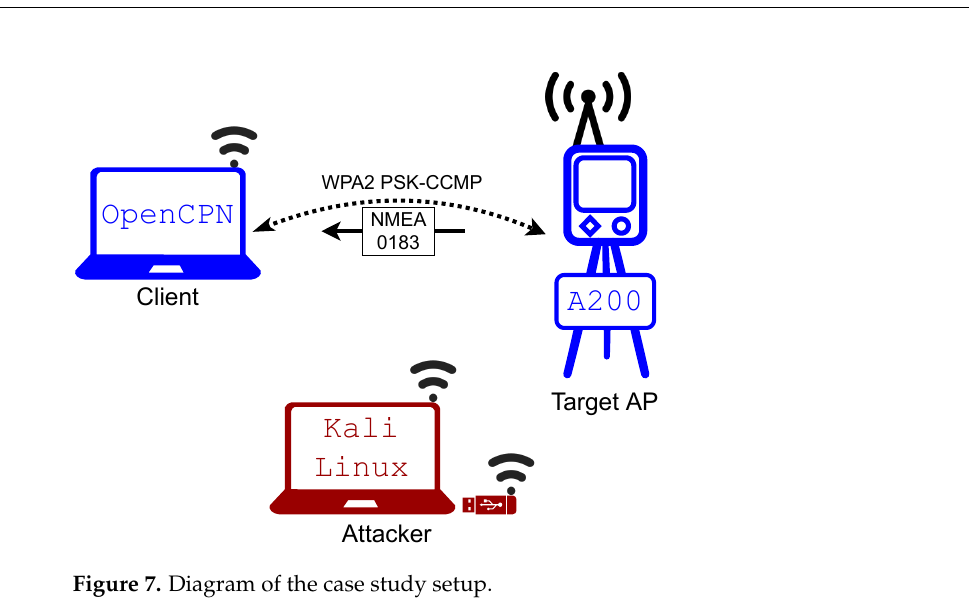
Figure 7. Diagram of the case study setup.